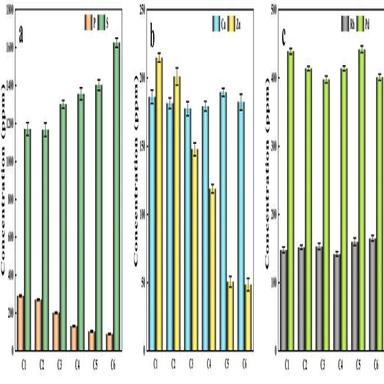
a) P, S, b) Zn, Ca, c) Rh and Pd concentrations obtained through ICP-MS.